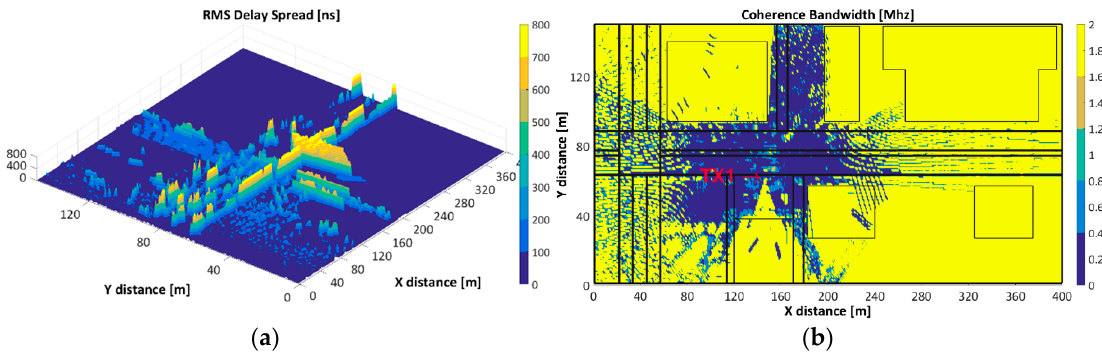
Figure 3. ( a ) RMS delay spread and ( b ) CB at Z-plane of 1.5